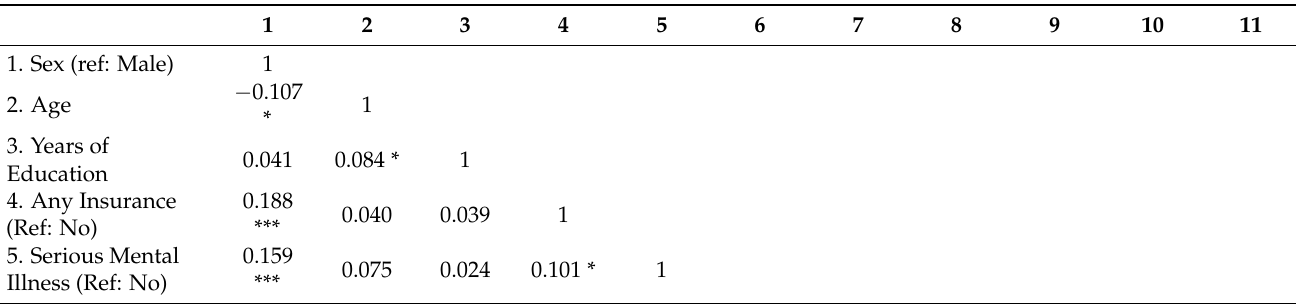
Table 2. Correlations between variables of interest among individuals experiencing homelessness in Oklahoma City, OK ( N =